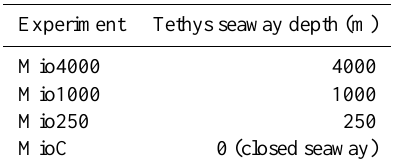
Fig. 1. Middle Miocene geography used in the Mio4000 experiment (Tethys seaway depth = 4000m). Table 1. Tethys seaway depth for each of the four sensitivity exper- iments.